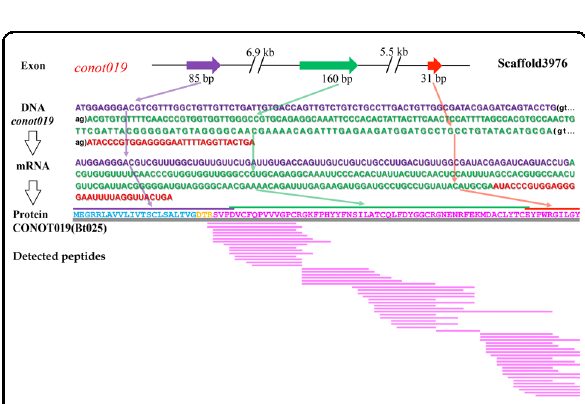
Fig. 8 A representative central dogma for the conopeptide Bt025. Regions in purple, green, and red colors represent the fi rst, second and third exons, or their corresponding DNA/mRNA sequences, respectively. Sequences highlighted in blue, orange, and rosy red are signal peptides, pro-peptides, and mature peptides,